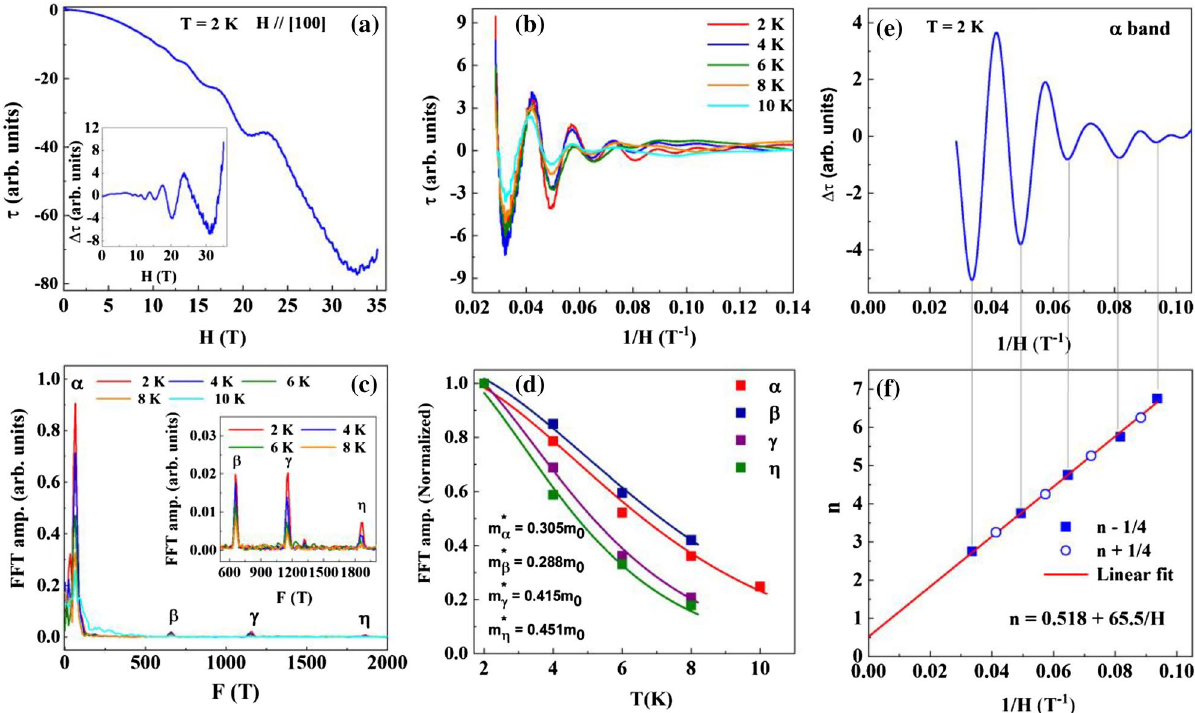
Figure 3. de Haas-van Alphen oscillations in magnetic torque of PdTe. ( a ) Field dependence of the magnetic torque of PdTe at 2 K under H // a . Inset: Δτ vs. H . ( b ) Δτ plotted as a function of H −1 at the indicated temperatures. ( c ) Fast Fourier Transformation (FFT) of the oscillatory torque presented in ( b ). The inset shows the enlarged FFT amplitude for the β, γ and η bands. ( d ) Temperature dependence of the FFT amplitudes for respective bands as indicated. Solid lines are the fit with thermal damping term of the LK formula. ( e ) de Haas- van Alphen oscillation at 2 K after applying a low pass filter of 100 T. ( f ) Landau fan diagram constructed from dHvA oscillation at 2 K for the α